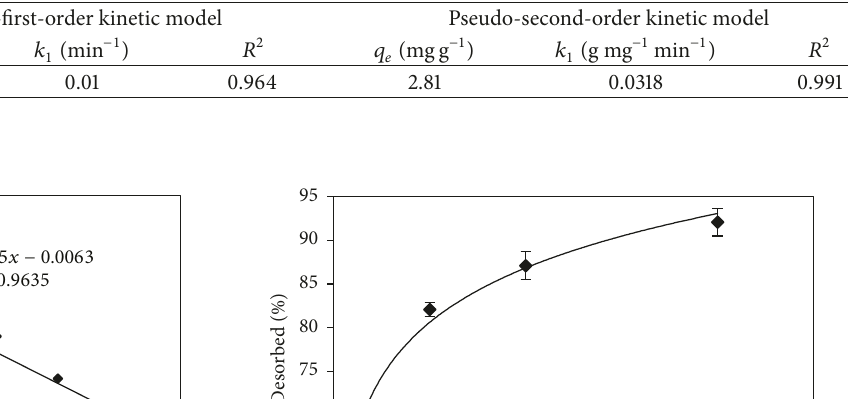
Table 7: Kinetic parameters.